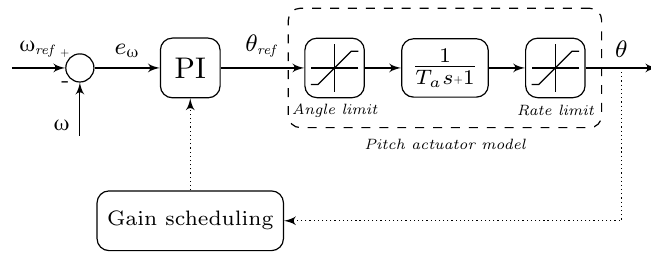
Figure 6. Pitch control